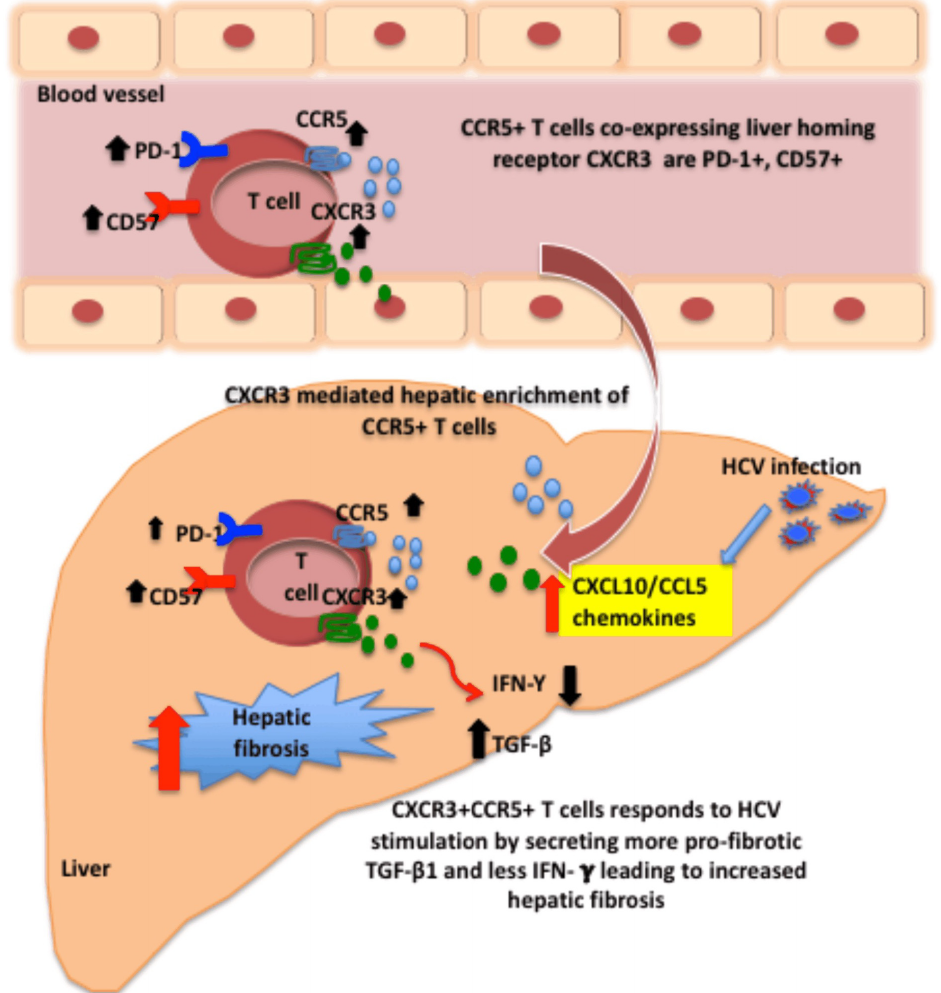
Figure 5. Graphical summary of this study. Hepatitis C virus infection in the liver of HIV infected patients stimulates the production of chemokines including CCL5 (RANTES), IP-10 (CXL10), which induces migration of CCR5+CXCR3+ T cells from the peripheral blood to the liver. These CCR5+CXCR3+ T cells infiltrating into the liver are chronically activated, terminally differentiated and have an exhausted phenotype. Upon HCV peptide stimulation, these cells secrete more pro-fibrogenic cytokine (TGF- β ) rather than antiviral cytokines (IFN- γ and IL-2), which may favor a profibrogenic intrahepatic microenvironment in HIV/HCV coinfection, causing advanced liver disease.